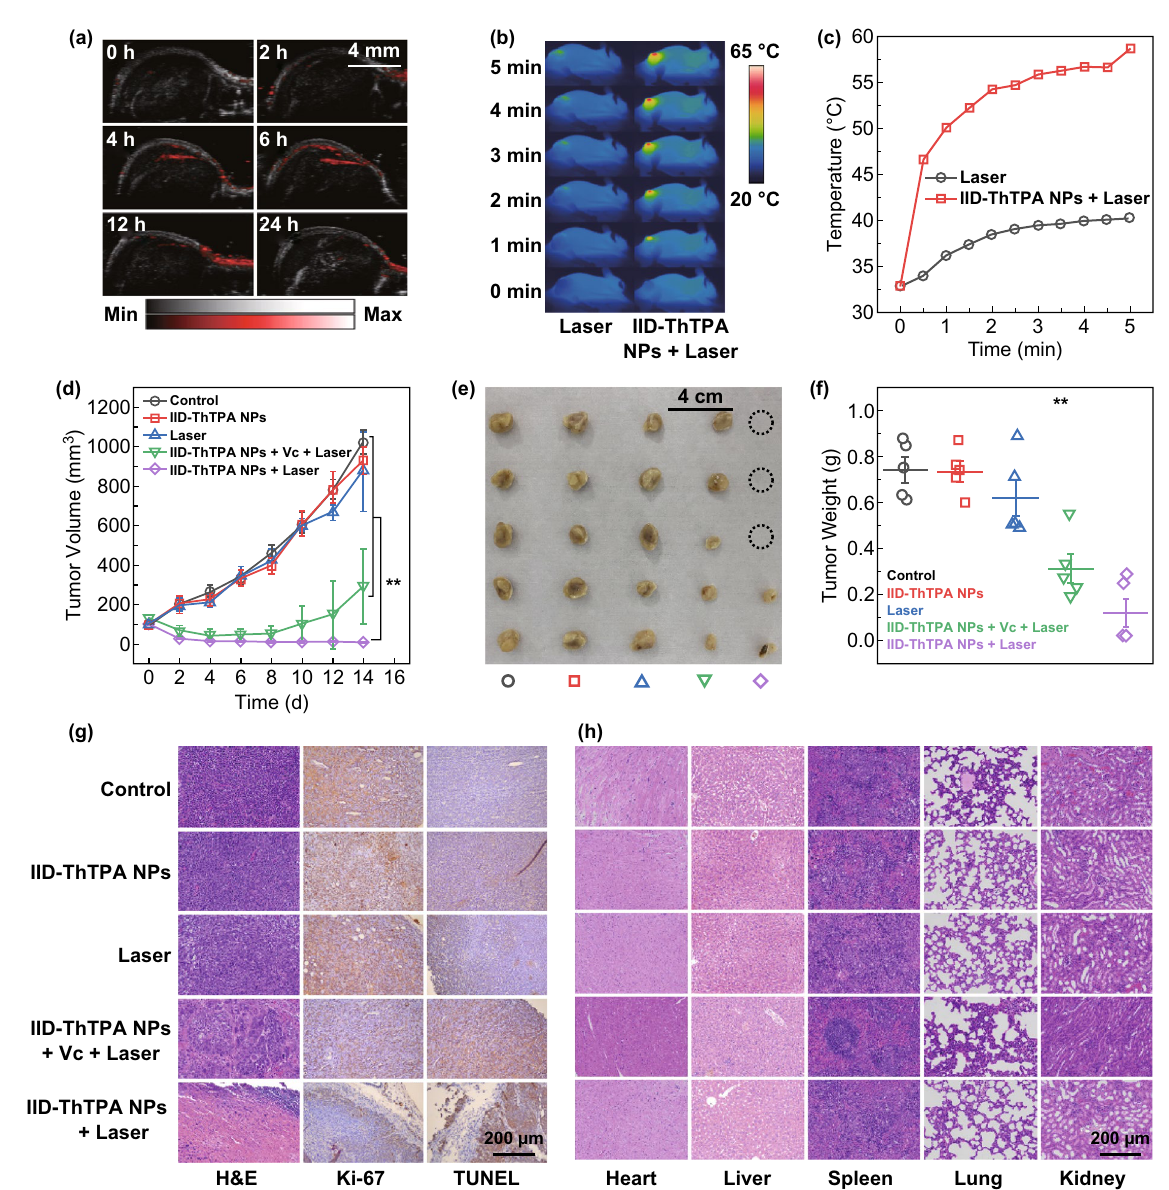
Fig. 5 In vivo PAI-guided phototherapy enabled by IID-ThTPA NPs. a PA images of the tumor sites at 680 nm at different time points post- injection (0, 2, 4, 6, 12, and 24 h). b Infrared thermographs of the mice under laser irradiation (671 nm, 1.00 W cm −2 ) in laser and IID-ThTPA NPs + laser groups. c Tumor temperature elevation curves of the mice under laser irradiation (671 nm, 1.00 W cm −2 ) in laser and IID-ThTPA NPs + laser groups. d Tumor volume variation curves of the mice in control, IID-ThTPA NPs, laser, IID-ThTPA NPs + Vc + laser (PTT), and IID-ThTPA NPs + laser (PTT + PDT) groups during the treatment period (the results are presented as mean ± SD, ** P < 0.01 by two-tailed unpaired Student’s t tests, n = 5). e Digital photographs of the tumors dissected from the mice in control, IID-ThTPA NPs, laser, IID-ThTPA NPs + Vc + laser (PTT), and IID-ThTPA NPs + laser (PTT + PDT) groups at the end of treatment. f Tumor weights of the mice in control, IID- ThTPA NPs, laser, IID-ThTPA NPs + Vc + laser (PTT), and IID-ThTPA NPs + laser (PTT + PDT) groups at the end of treatment (the results are presented as mean ± SD, ** P < 0.01 by two-tailed unpaired Student’s t tests, n = 5). g H&E, Ki-67, and TUNEL staining of tumors of the mice after different treatments. h H&E staining of the major organs (heart, liver, spleen, lung, and kidney) of the mice after different